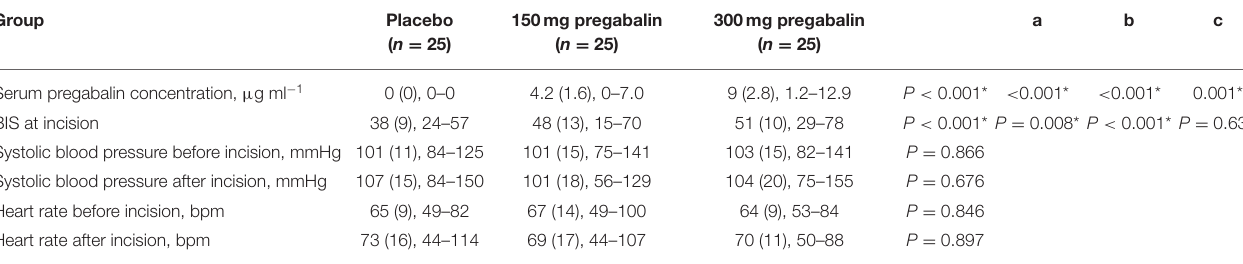
TABLE 3 | Serum pregabalin concentration, bispectral index, blood pressure, and heart rate at different time points in the study groups.